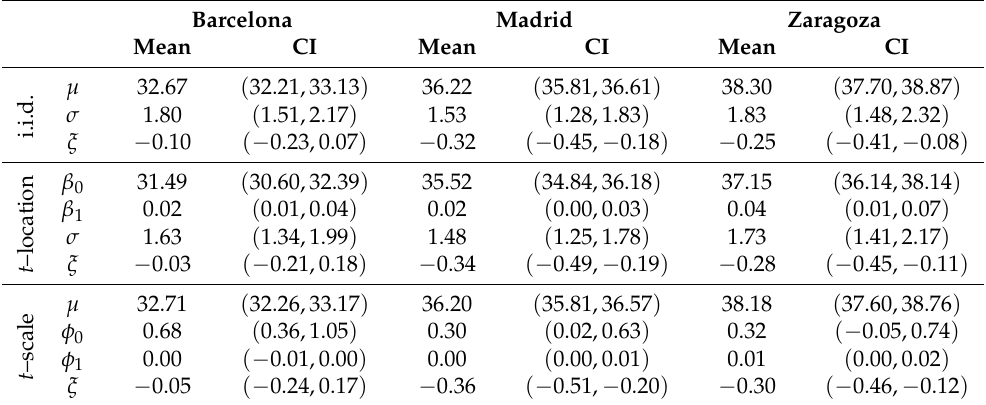
Table A1. Posterior mean and 95% CI of the GEV models including constant parameters and linear time-trends in location or scale.